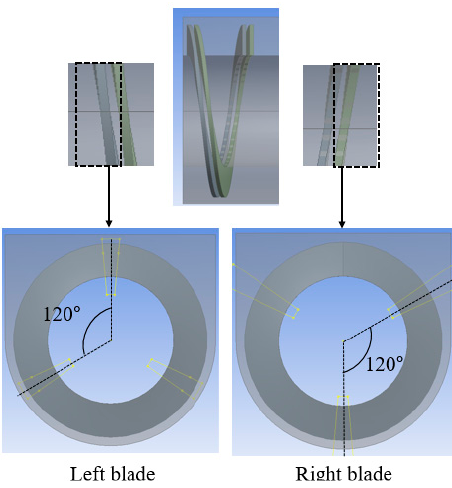
Figure 14. Arrangement in gas of left and right blades.